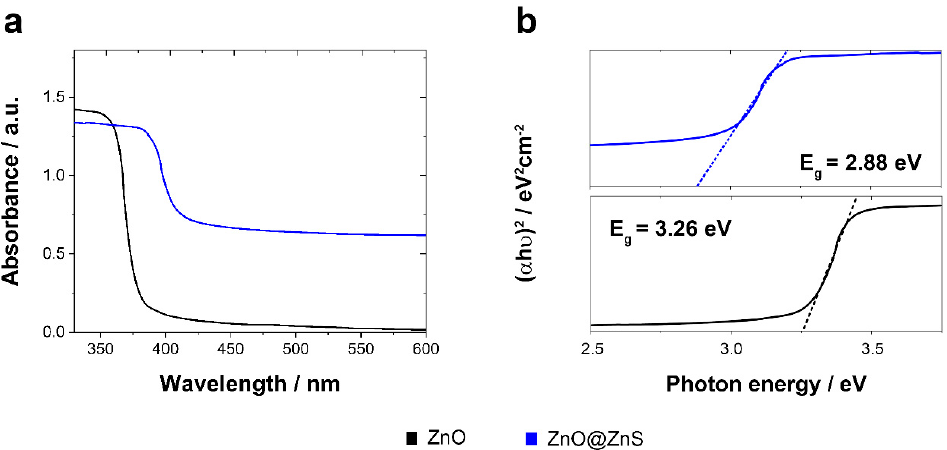
Figure 3. ( a ) UV-vis DRS absorption spectra and ( b ) Tauc plots from the UV-vis analysis of ZnO and ZnO@ZnS(4 h) micro/nanoferns.